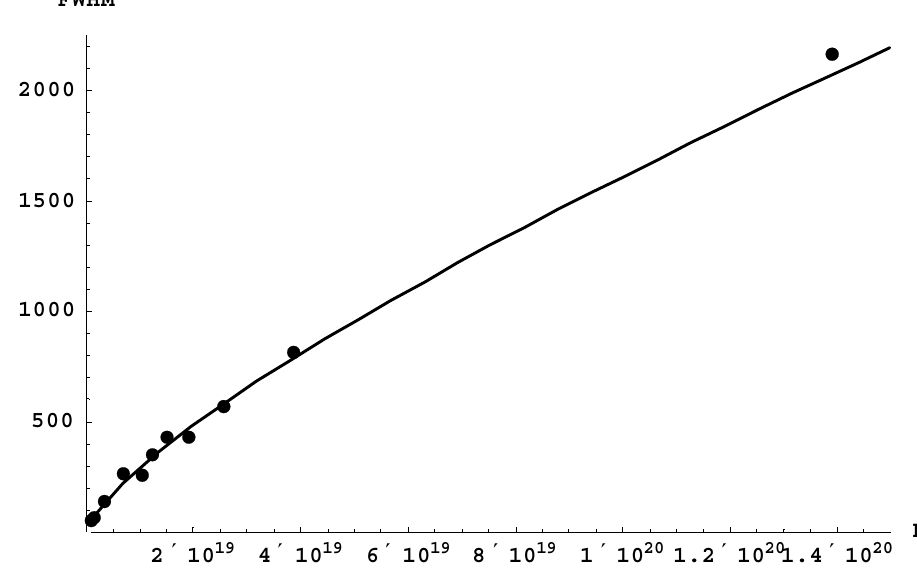
Figure 22. Comparison of the experimental FWHM of the H α line from Kielkopf–Allard experiment [109] (dots) with the corresponding FWHM yielded by our present analytical theory (solid line). The FWHM is measured in Angstrom, while N e —in cm − 3 [115].